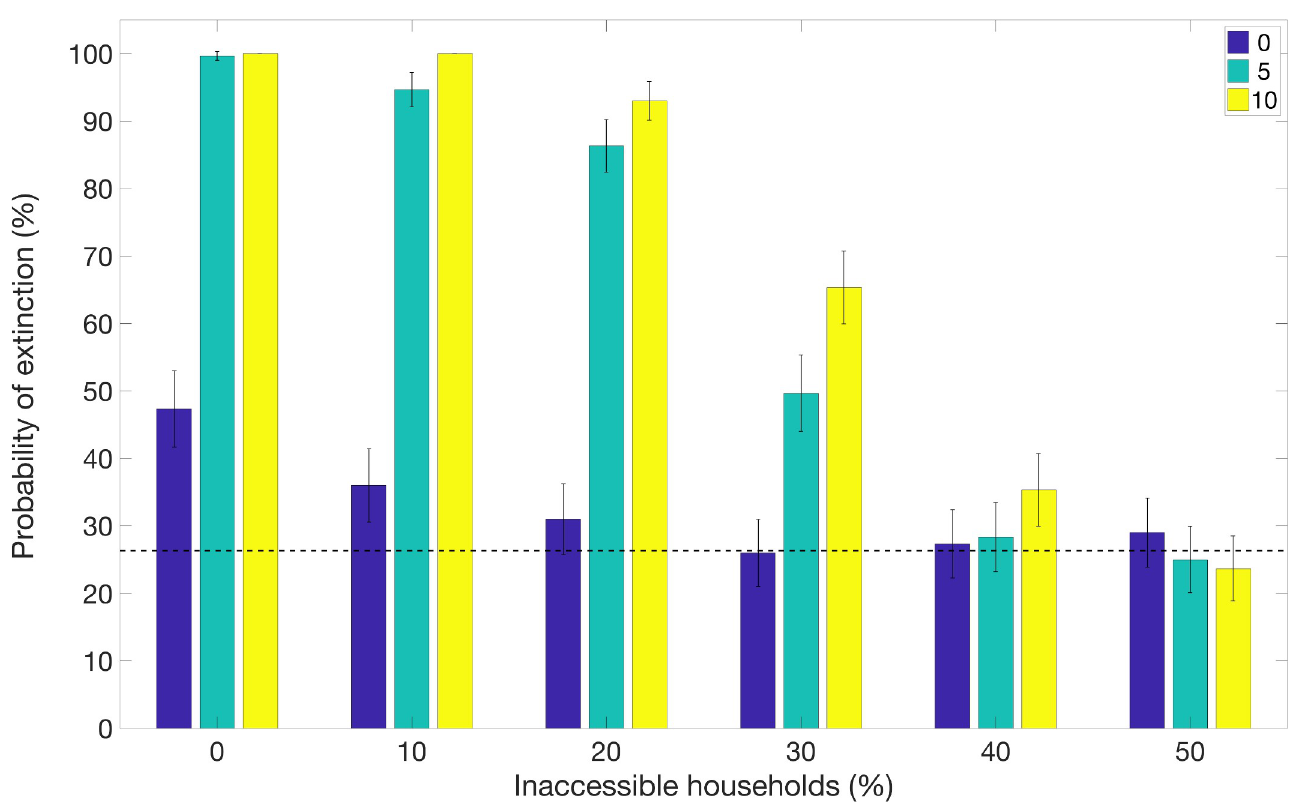
Fig 10. Supplemental effect of community vaccination on the probability of epidemic extinction for populations with different household inaccessibility levels ranging from 0 to 50%. Bars show the probability of epidemic extinction after 1.5 years for increasing vaccination measures: i) ring vaccination alone (blue bars), ii) ring vaccination with supplemental community vaccination with a rate of 5% community vaccination per day (light blue bars) and iii) ring vaccination with supplemental community vaccination with a rate of 10% vaccination per day. The horizontal line indicates the mean probability of extinction for the baseline scenario in the absence of vaccination. Timing was chosen to resemble the scenario for the DRC Ebola epidemic, with ring vaccination applied after 7 days and community vaccination applied after 9 months. These simulations were generated using the exponential transmission profile, but qualitatively similar results were obtained using the gravity transmission profile described in the main